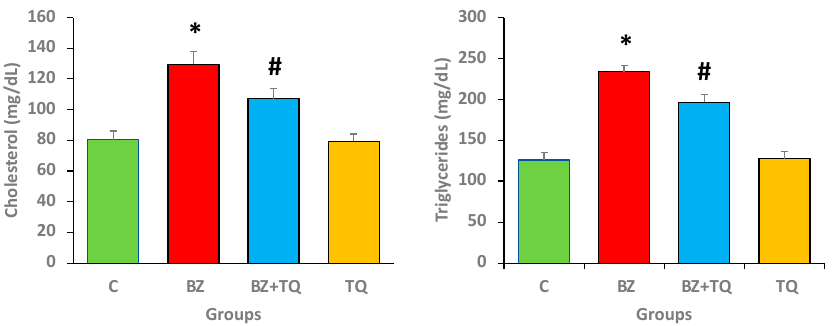
Figure 1. The lipid profile as cholesterol and triglyceride levels in different animal groups. The values indicate the mean ± SEM, with 8 animals/group. The animals administered with B(a)P showed these parameters at significantly higher levels than the control group. The TQ (50 mg/kg b.w.) promoted a significant reduction in lipid profile. The statistical differences are denoted with an asterisk (*), indicating significance at p < 0.05 in comparison with the control group, and a hashtag (#), signifying p < 0.05 in comparison with the disease control.